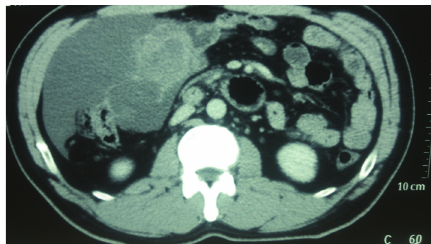
Figure 1: Contrast enhanced computed tomography (CECT) of abdomen and pelvis showing similar size irregular multiseptated multicystic lesion engulfing the ascending colon and caecum. Bowel lumen showed no growth. CECT abdomen showing an irregular multiseptated lesion lying over the ascending colon.